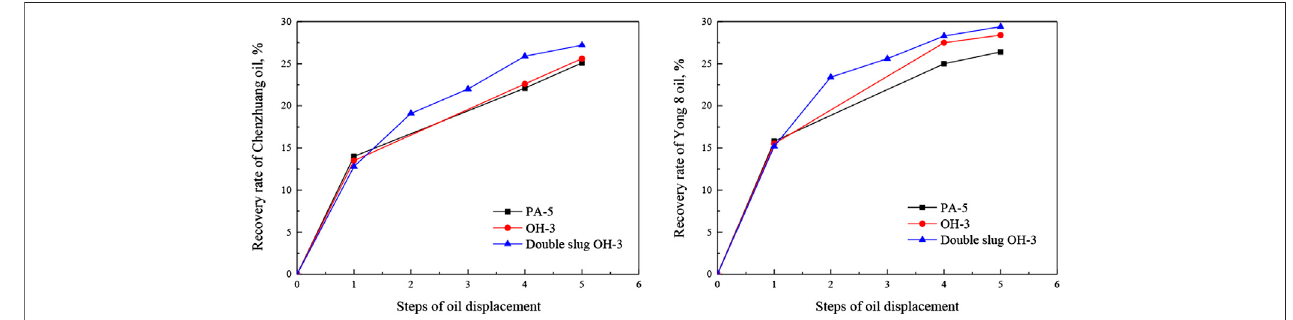
FIGURE 7 | Double slug experiment of the homogeneous formation of the visualization glass plate model.